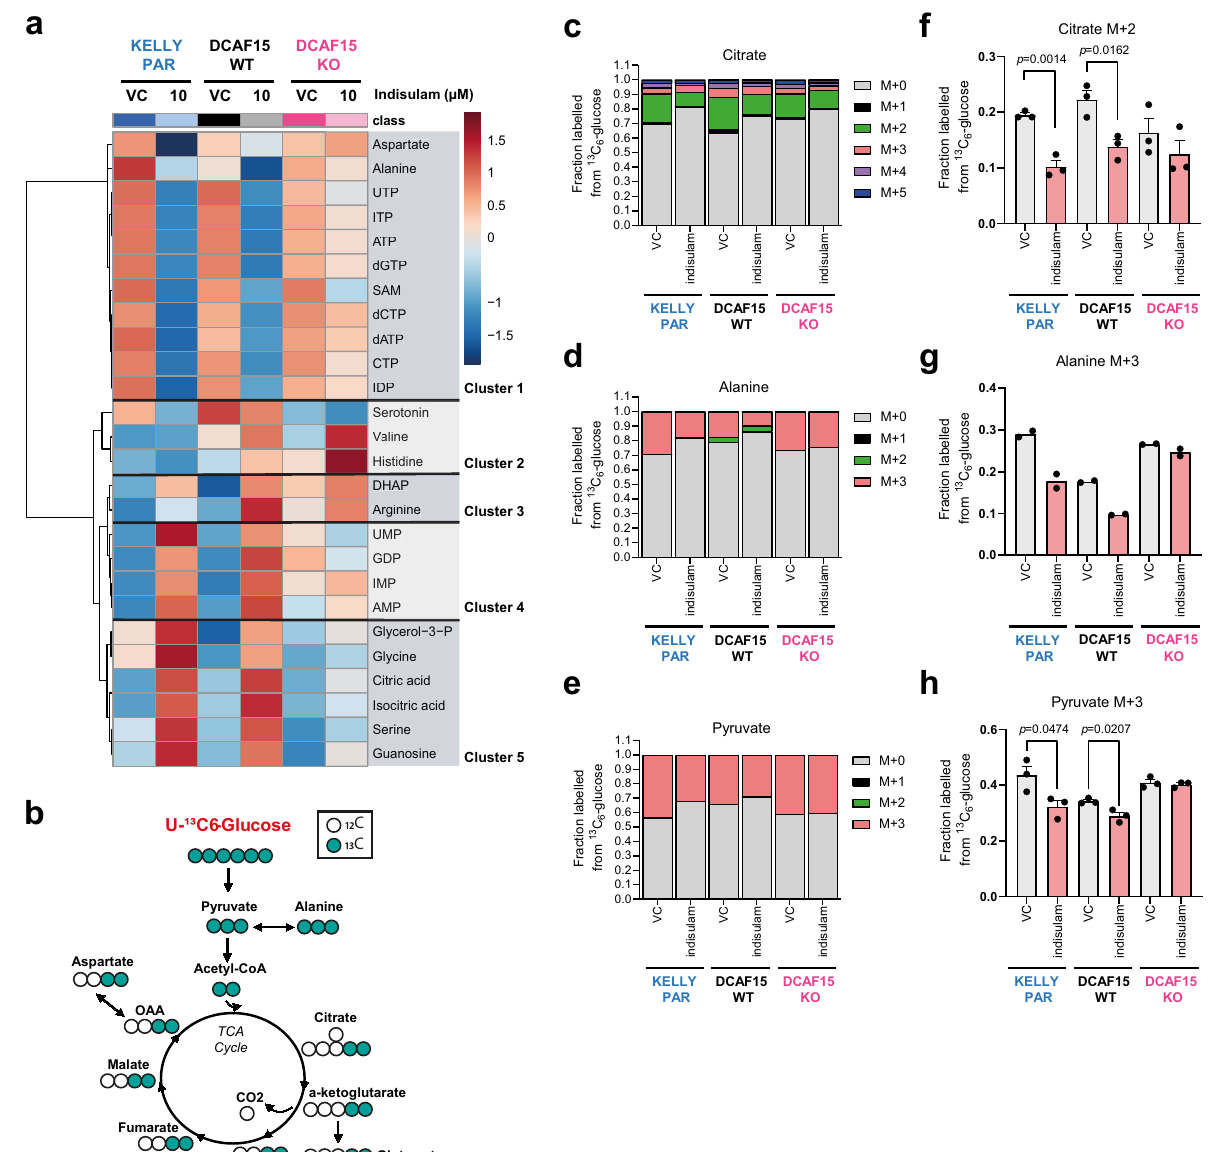
Fig. 5 Indisulam modulates the metabolome and glucose utilisation. a KELLY Parental (PAR), DCAF15 WT or DCAF15 KO dosed with vehicle control (VC, 0.1% DMSO) or 10 µ M indisulam for 24 h and intracellular metabolites analysed by HILIC LC – MS/MS. Heatmap showing hierarchal clustering of signi fi cantly altered metabolites ( p -adj < 0.001, Kruskal – Wallis test, MetaboAnalyst). Data are an average of four technical replicates of n = 2 independent experiments. b Schematic representation of enrichment of 13 C derived from 13 C 6 -glucose into TCA cycle intermediates detected by GC-MS. c – h KELLY PARENTAL (PAR), DCAF15 WT or DCAF15 KO cells were exposed to indisulam in the presence of 5.6 mM 13 C 6 -glucose for 24 h. Fraction of carbons labelled from 13 C 6 -Glucose in Citrate ( c ), Alanine ( d ) and Pyruvate ( e ). M + n : a m e tabolite with n carbon atoms labelled with 13 C. Data are mean of n = 3 indepe n dent experiments, n = 2 for Alanine. Changes in M + 2 labelled Citrate ( f ), M + 3 labelled Alanine ( g ) and M + 3 labelled Pyruvate ( h ) following indisulam exposure. ( n = 3 indepe n dent experiments, n = 2 for Alanine). Data are presented as mean values ± SEM ( f – h ). Statistical signi fi cance in f and h was determined by a two-sided unpaired t -test. Source data is provided as a Source Data File. UTP uridine triphosphate, ITP inosine triphosphate,